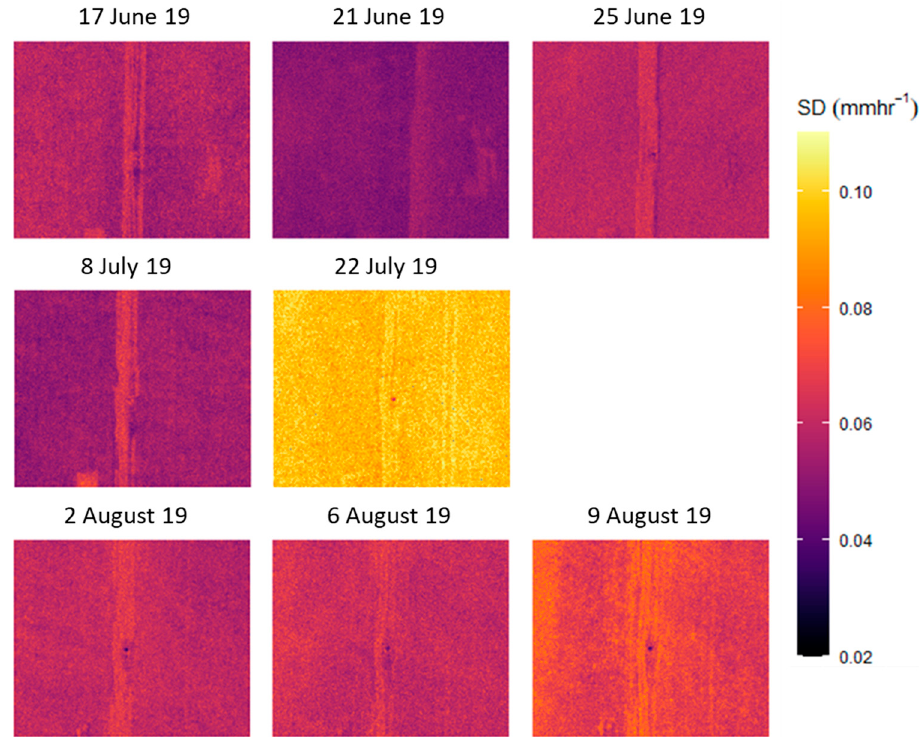
Figure 9. Standard deviation of HRMET-derived ET based on Monte Carlo analysis for each mission. Raster maps were only created for the 90 m elevation.